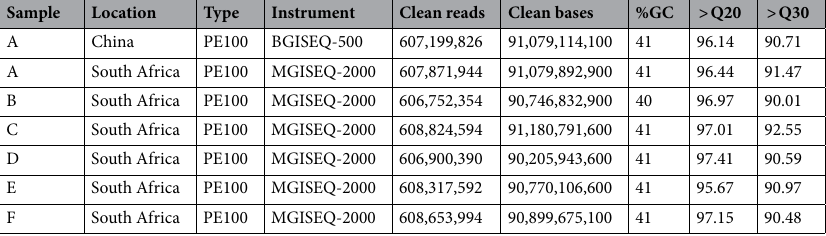
Table 1. Summary of the